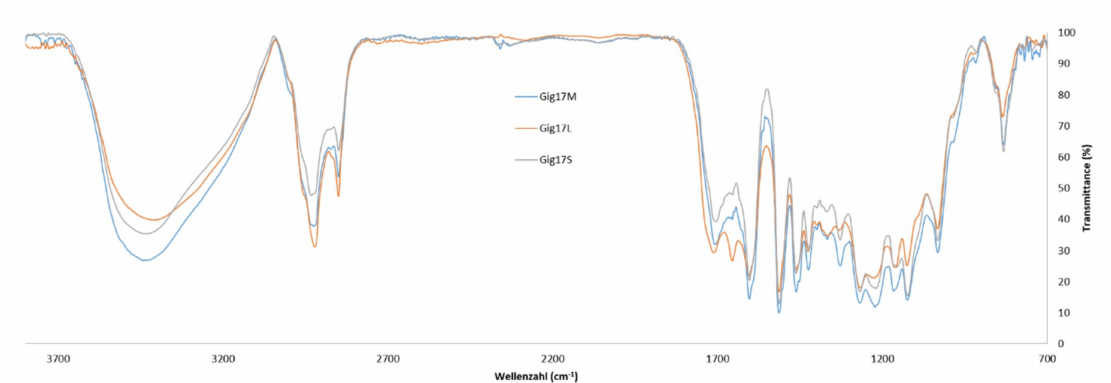
Figure 4. FT-IR spectra of mixture (Gig17M), leaf (Gig17L), and stem-derived (Gig17S) lignins obtained from M. x giganteus (Gig17).